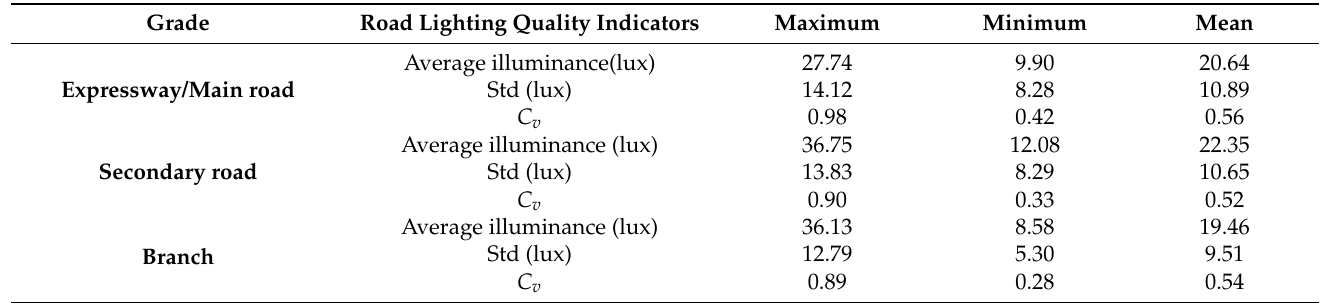
Table 6. The statistics of road lighting quality indicators for each road grade.